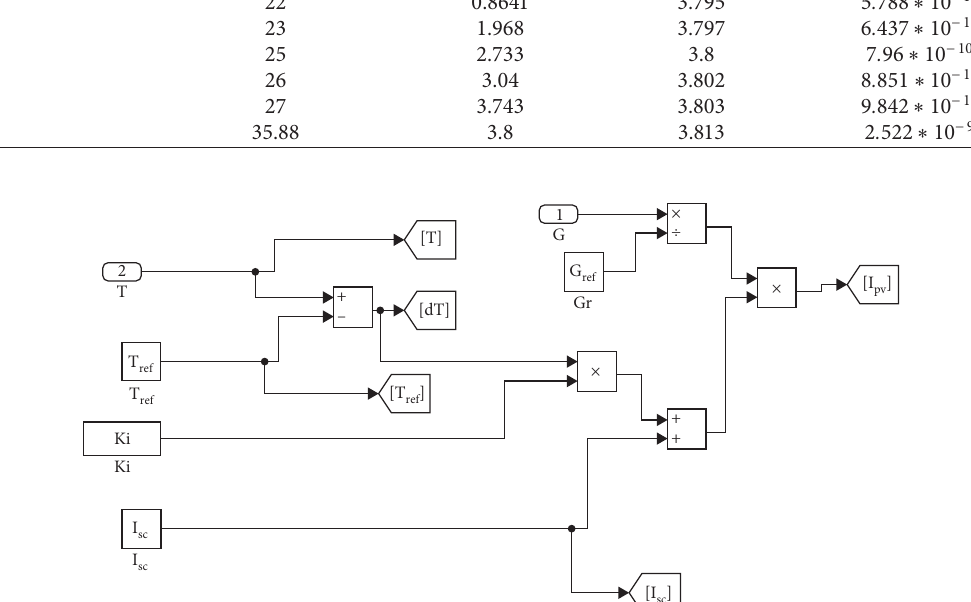
Figure 18: Modelled and implemented I